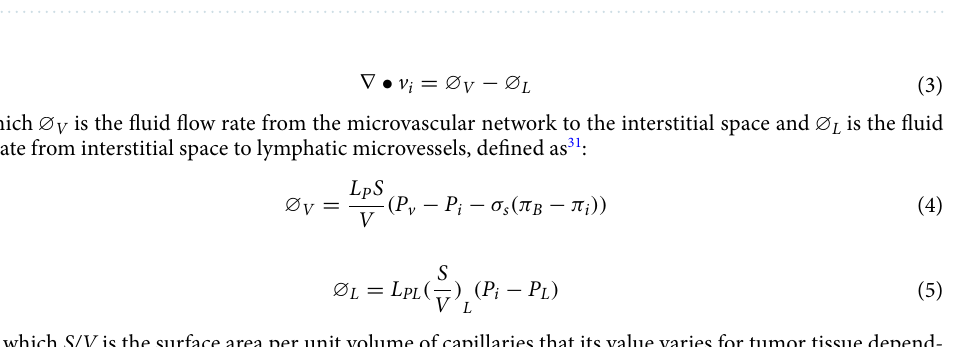
Table 1. Release rates at various pH